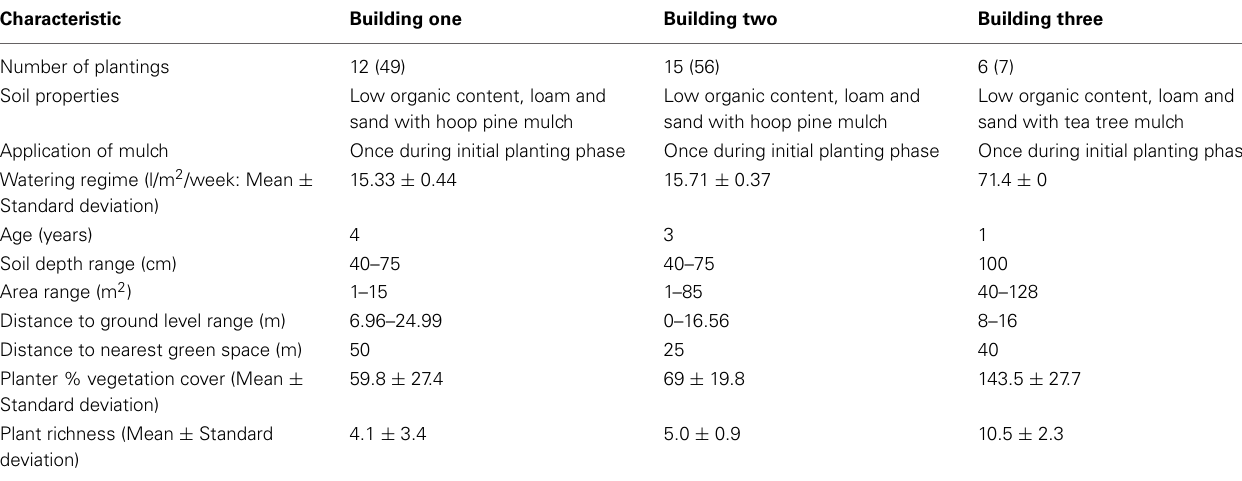
Table 1 | Summary of sites and planter characteristics including number of plantings sampled number sampled (total number present), soil properties, age, water regime, and soil depth information was obtained from interviews with building